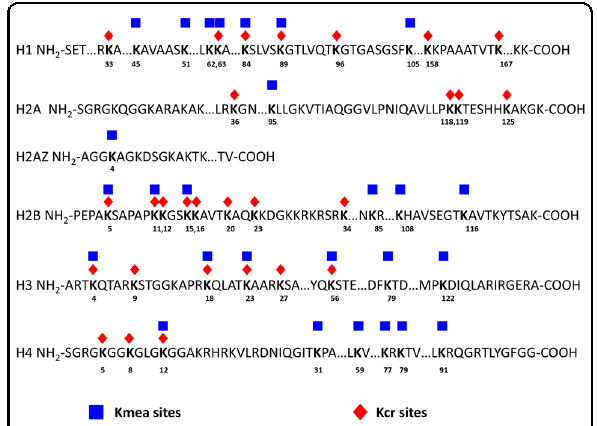
Fig. 4 Maps of the identi fi ed Kmea and Kcr on HeLa histones. Schematic of the sequences of the 5 core histone proteins and 1 variant histone sequence (H2AZ) with sites of Kmea and Kcr identi fi ed in HeLa cells. The key for the modi fi cations is as follows: Kmea, blue squares; Kcr, orange diamonds. Kmea sites include both those detected by IP-HPLC/MS/MS with pan Kmea antibody as well as sites that were validated by co-elution or ozonolysis in HeLa cells. Kcr sites were detected in our previous publication using HeLa cell histones 11